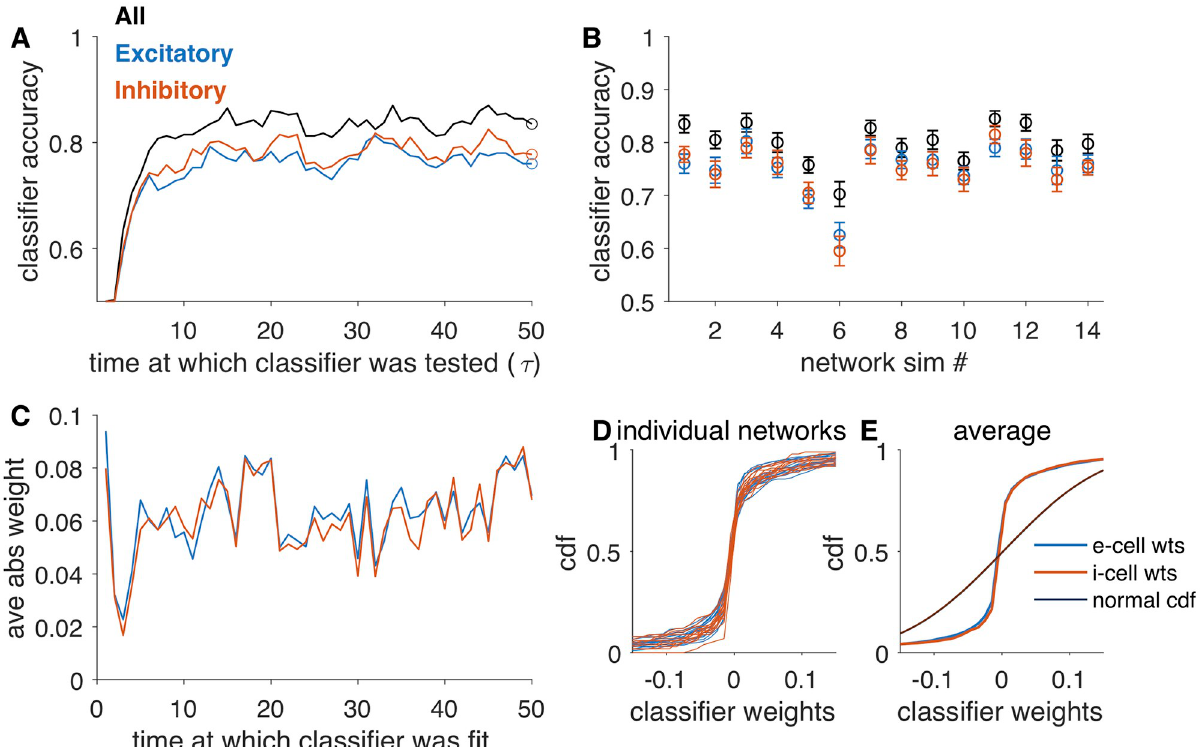
Fig 3. Classifiers decode stimulus identity from recurrent network activity. A: Accuracy of a classifier over the course of the stimulus presentation. For each set of cells (all, black; 100 e-cells, blue; 100 i-cells, red), we fit the classifier at a single point in time (circle) and classified activity over the trial. B: Accuracy of classifier across network instances (same order as Fig 2). Error bars are ± 1SE estimated by cross-validation (see Methods). C—E: Characterization of classifier weights. C: Weights for classifiers fit on the activity of all cells at each point in time in the stimulus presentation window. Weights from excitatory units are blue and from inhibitory units are red. D: Cumulative distribution of weights in each of the networks, for excitatory (blue) and inhibitory (red) cells. E: Average of CDFs shown in D. Distributions are overlapping for excitatory and inhibitory cells. For reference, we also plot the CDF of a normal distribution with standard deviation matched to that of weight distributions